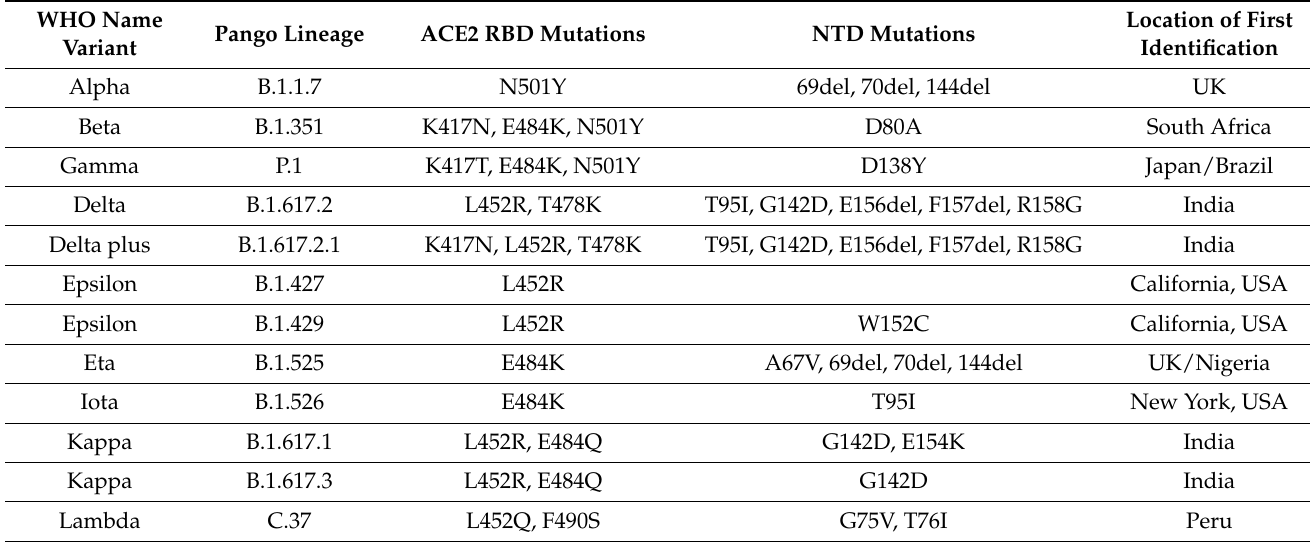
Table 3. Summary of using ACE2 RBD/NTD sequencing for variant categorization. Both the CDC and the WHO have designated Alpha, Beta, Gamma, and Delta as the